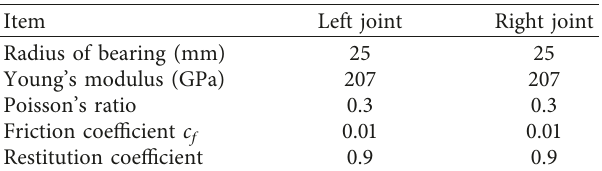
Figure 13: Installation positions of five sensors in the right 3D